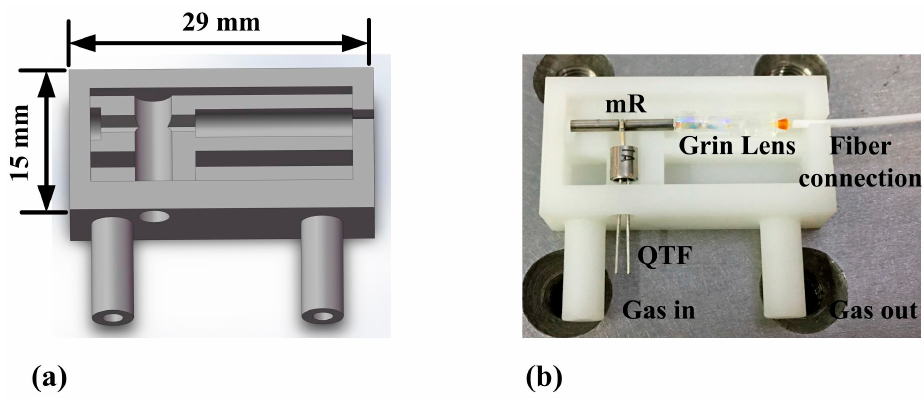
Figure 1. ( a ) 3D model; ( b ) 3D-printed ADM containing QTF, grin lens and